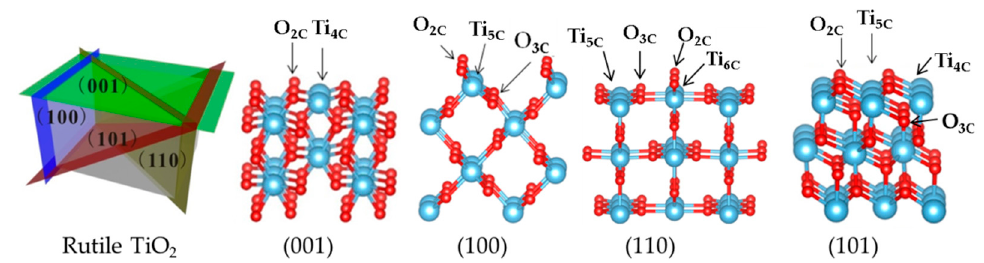
Figure 1. Side views of rutile TiO 2 (001), (100), (110), and (101) surfaces. Note: Ti, blue; O, red. Table 1. Size, composition, layers, and coordination numbers of atomic surface.